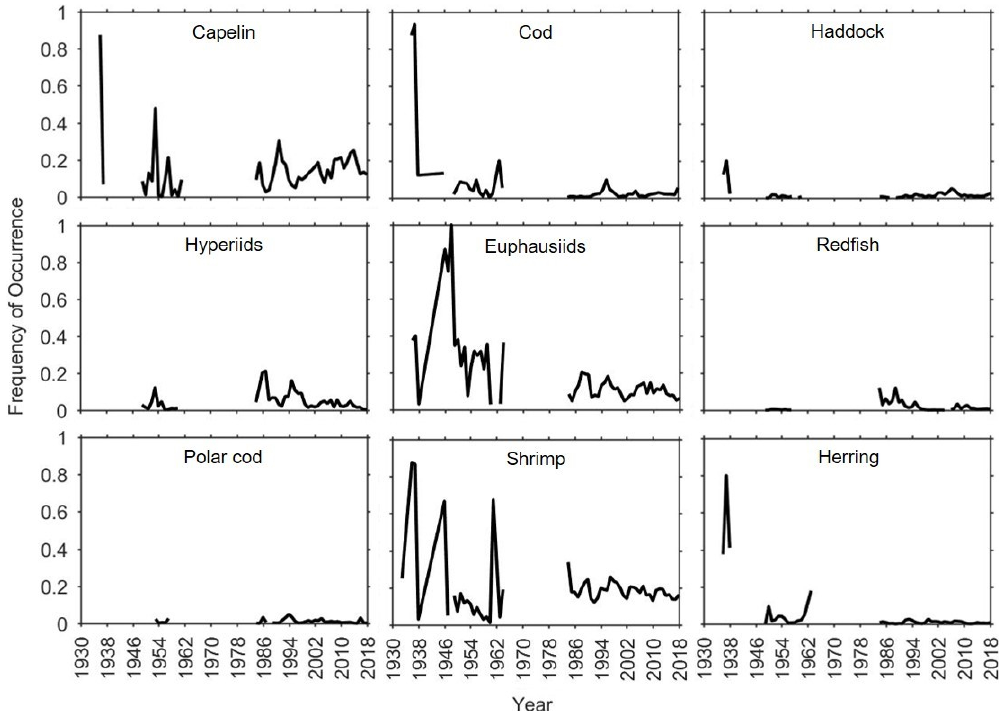
Figure 6. Time series of occurrence of the main prey items in the dataset, excluding empty stomachs. The frequency of occurrence of each prey item is calculated based on the total number of stomachs in each